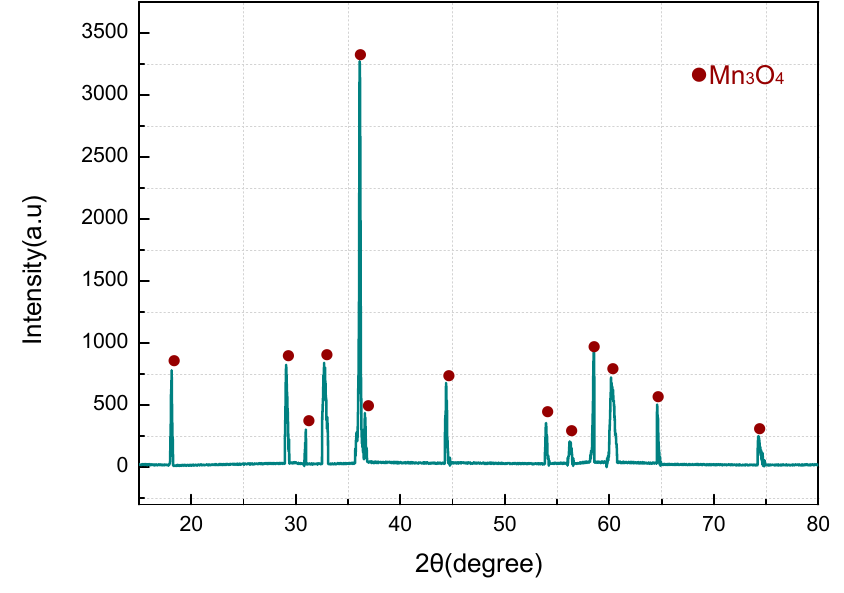
Figure 10. XRD map of PTFE/MnO 2 after reaction.